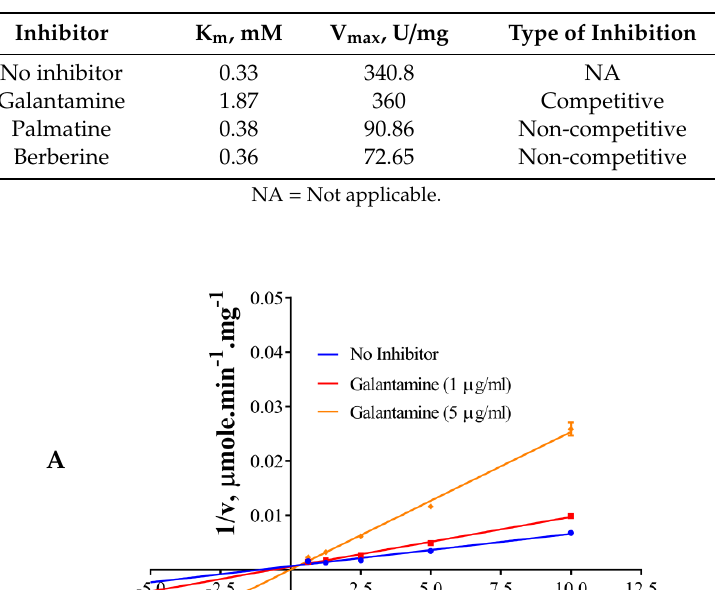
Figure 3. Overlap chromatographs of ( A ) the standard mix of ferulic acid (1, 22.16 min), palmatine (2,